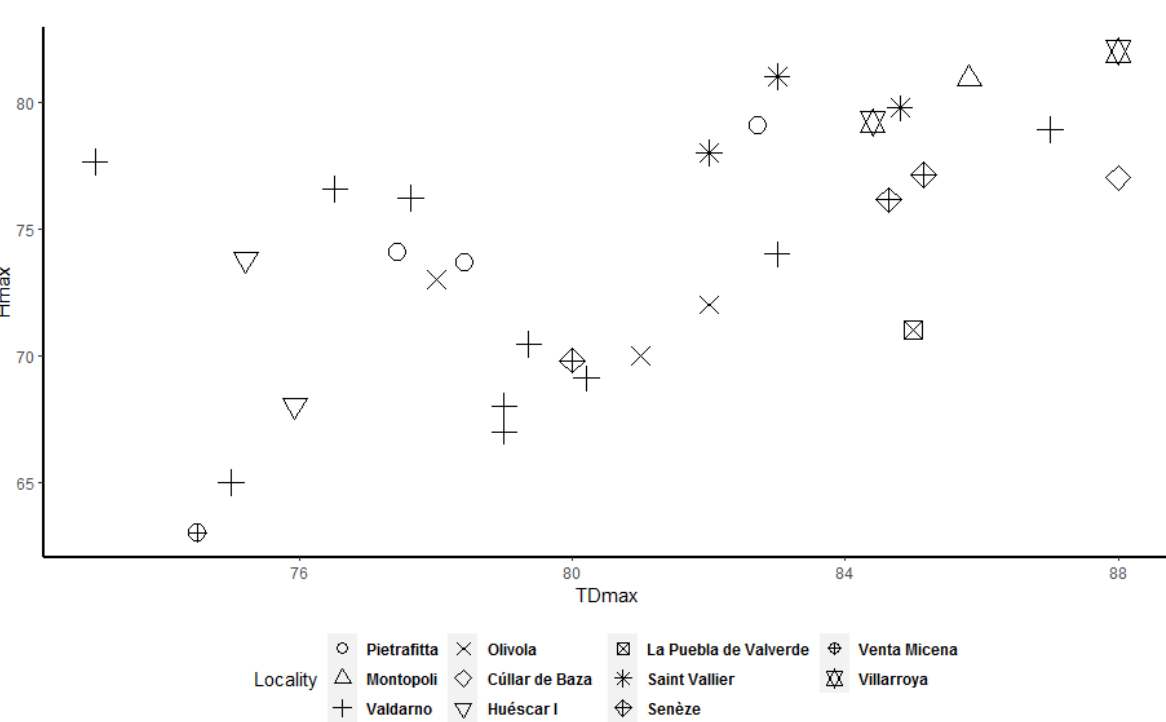
Figure 8. Scatterplot between the maximum length (Lmax) and the proximal transverse diameter (PTD) of the tibia.